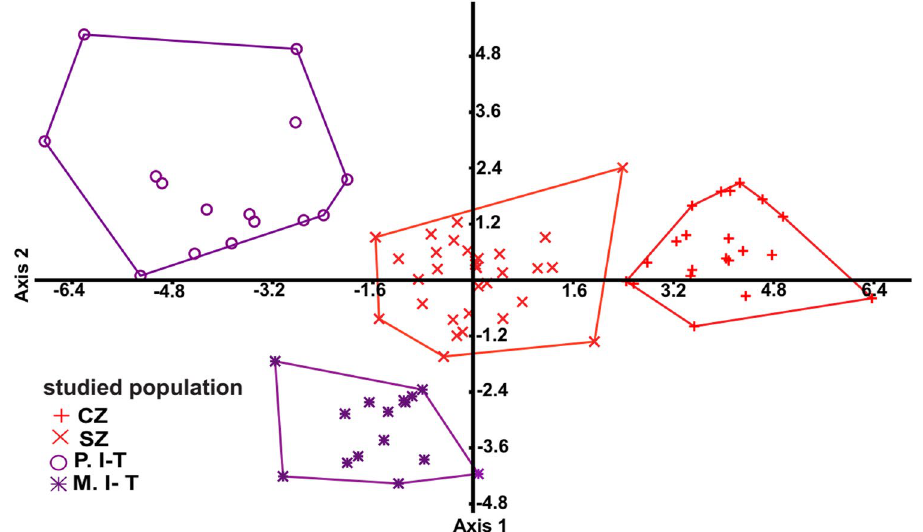
Figure 6. Scatter plot of the two first canonical axes resulted from canonical variate analysis, showing the distribution of T. graeca populations in Central Iran.